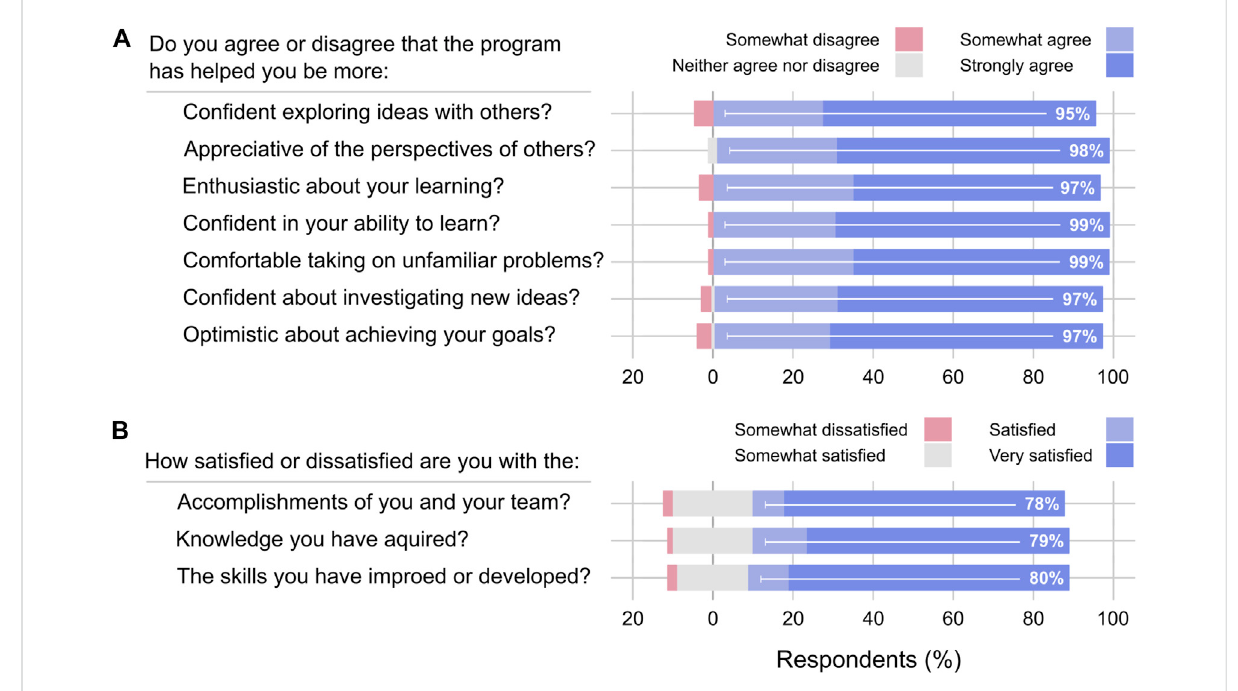
FIGURE 3 Learning outcomes. (A) Personal development. (B) Personal achievements. Each horizontal bar includes the percentage of respondents selecting the two highest options on a fi ve-point Likert scale. None of the respondents chose the lowest option (unacceptable, strongly disagree, or very dissatis fi